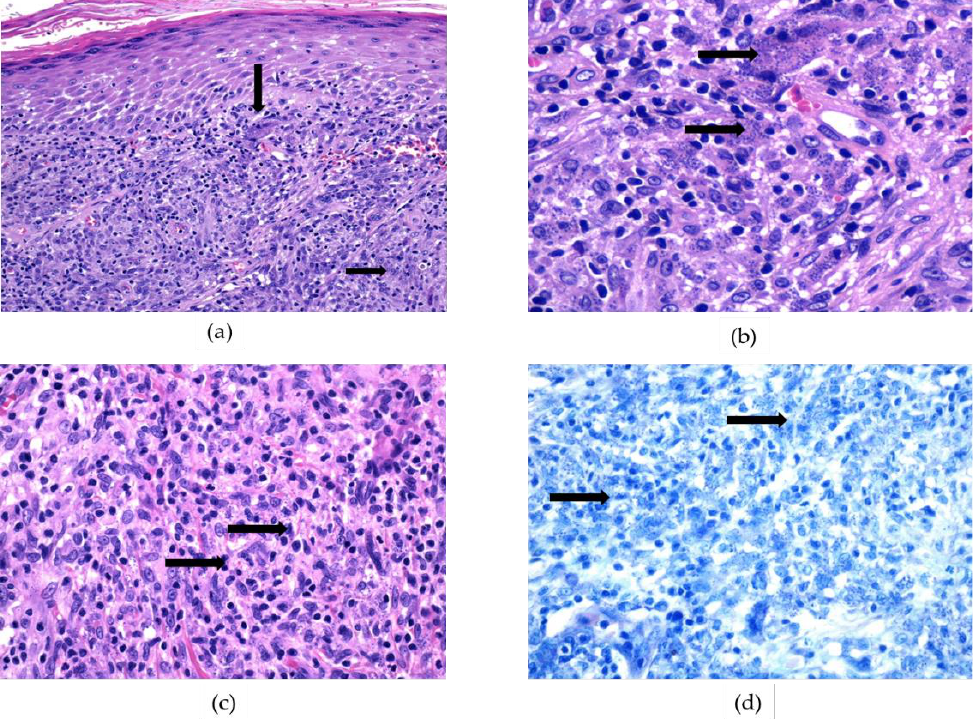
Figure 6. Histological diagnosis of tegumentary leishmaniasis: haematoxylin-eosin and Giemsa staining. ( a , b ): Hematoxylin-eosin (HE) staining reveals many amastigotes that appear as